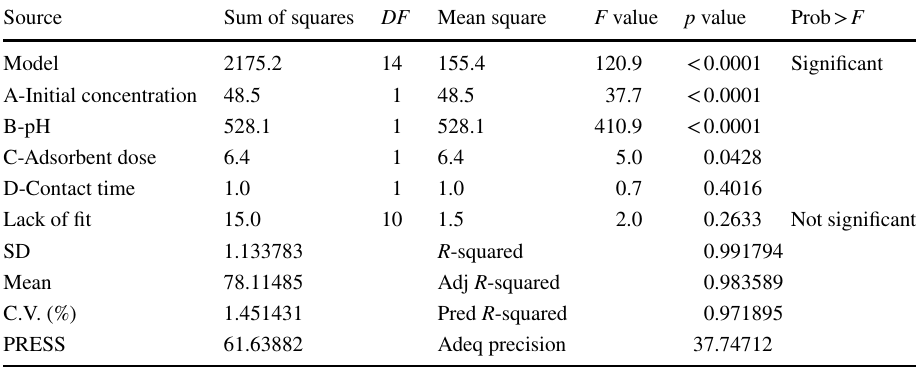
Table 3 Analysis of variance (ANOVA) for adsorption of carbaryl onto